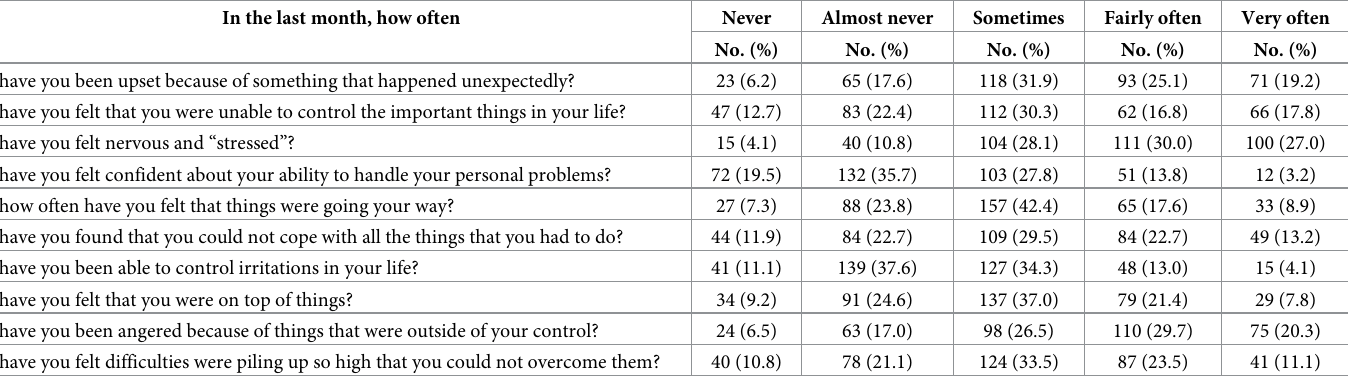
Table 2. Physicians’ response to perceived stress